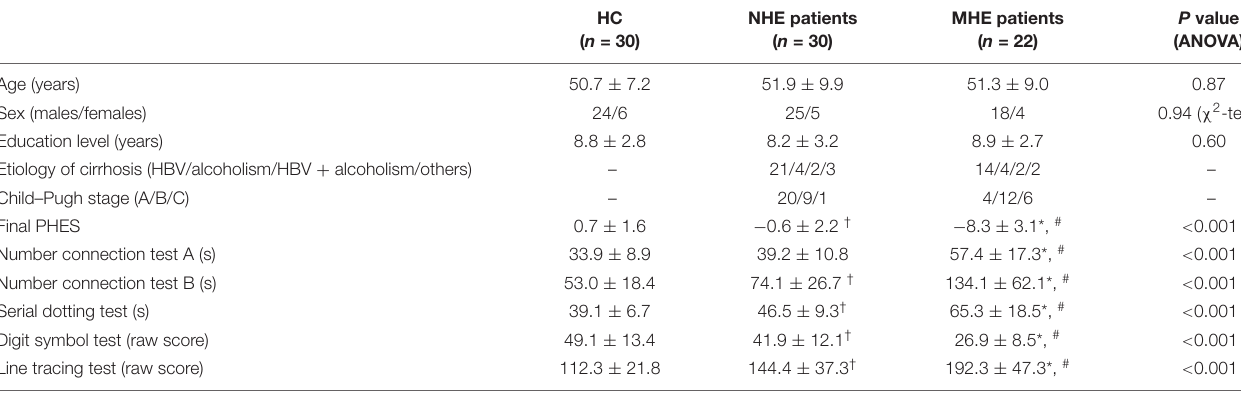
TABLE 1 | Demographics and clinical characteristics of the study